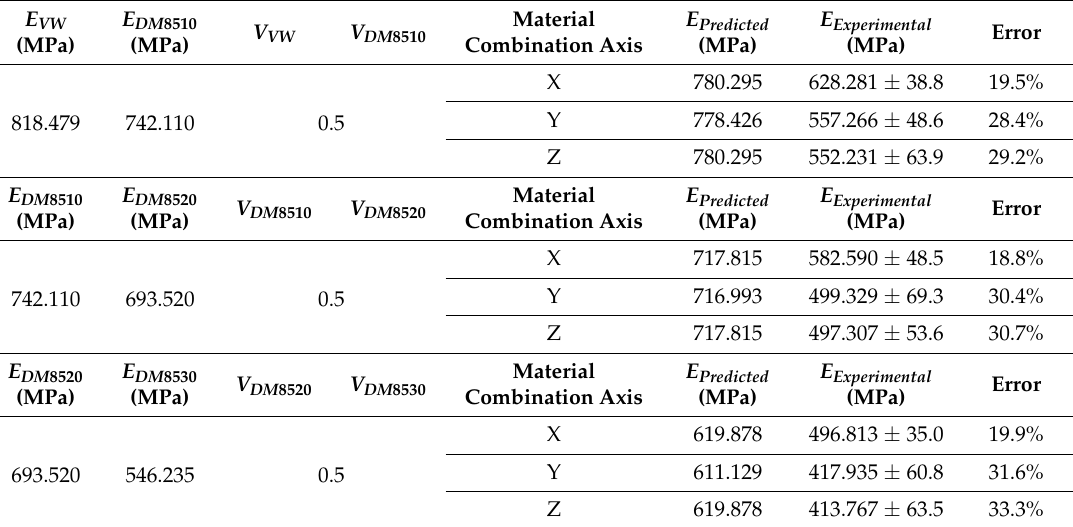
Table 5. Young’s Modulus comparison for multi-material